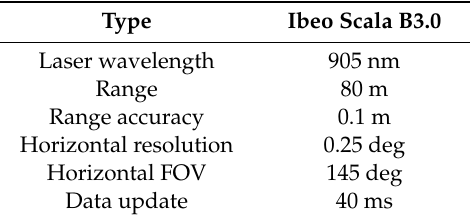
Table 2. Automotive lidar specifications.